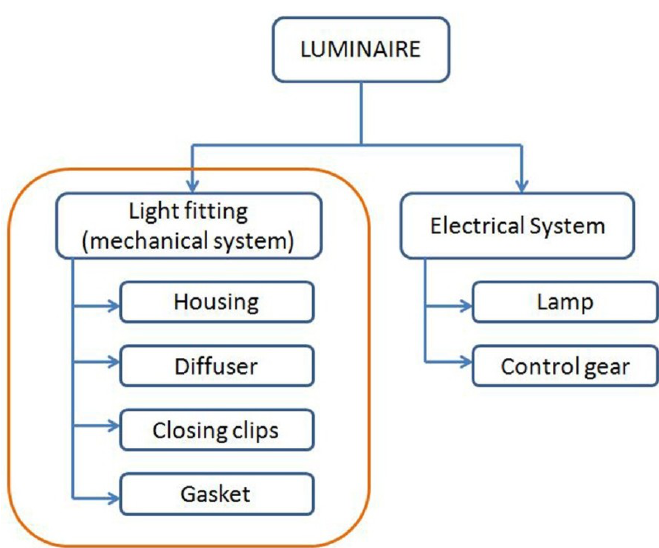
Figure 1. Product